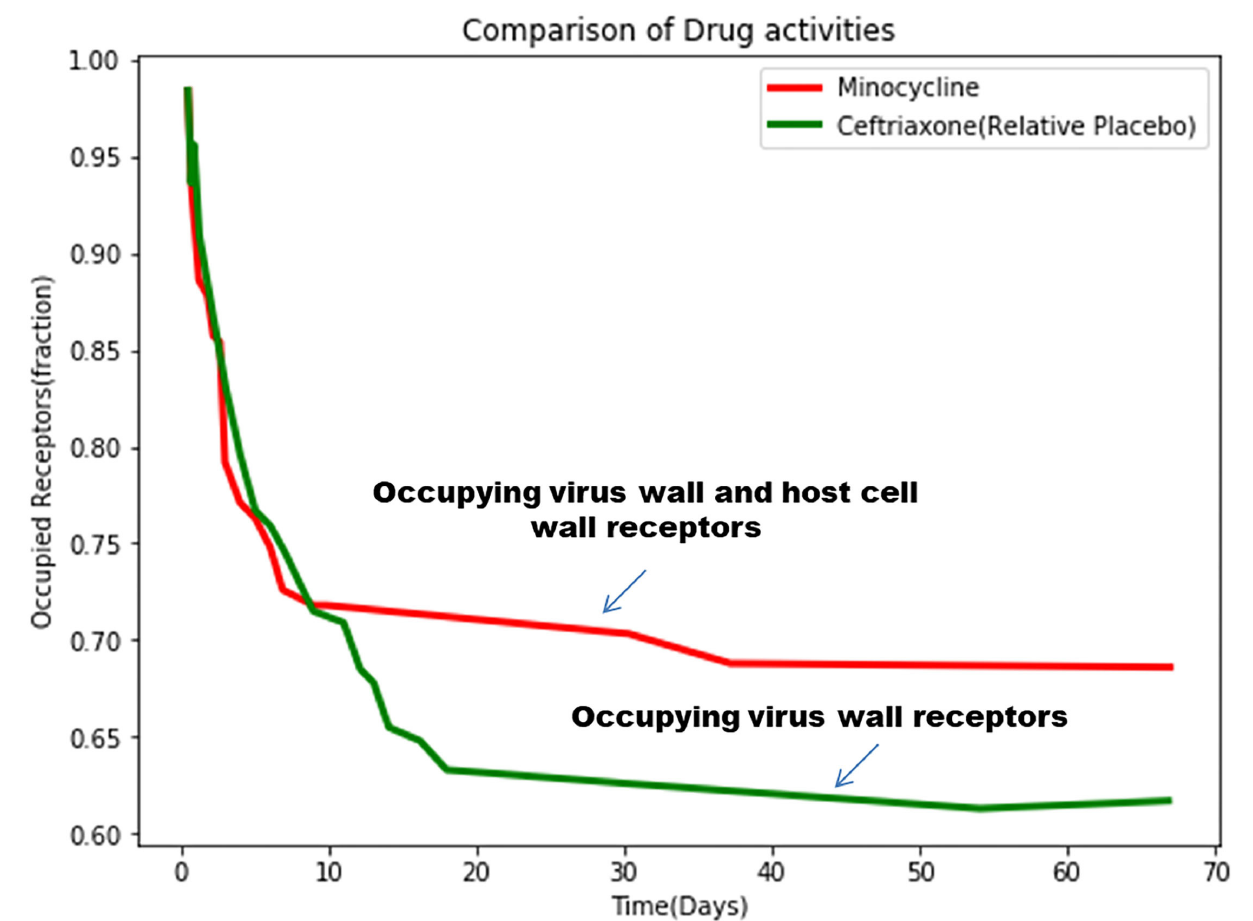
FIGURE 12 | The simulated mathematical model of drug activities toward receptors based on the clinical trial study.